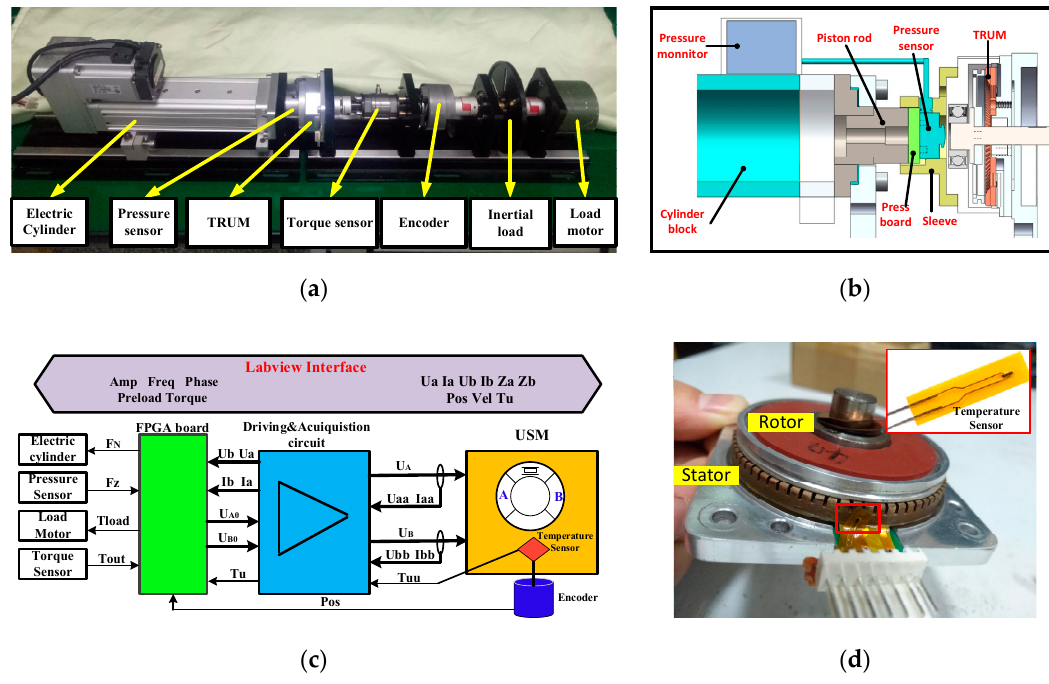
Figure 2. The integrated test system: ( a ) mechanical test bench; ( b ) structure scheme of the preload force regulating device; ( c ) framework and signal flow of the system; ( d ) the thin-temperature sensor placed near the interface.